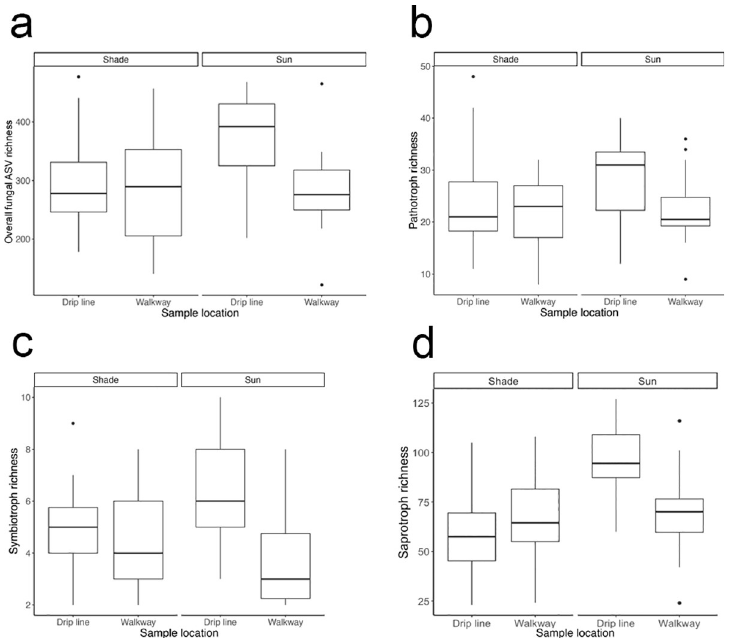
Fig 4. Boxplots of overall fungal richness and trophic mode richness by system and sampling depth. Each subfigure is plotted with system by sample location, but the interaction was only significant for subfigure d. Coffee soil collected in the drip line had higher a. overall fungal ASV richness, b. pathotroph richness, and c. symbiotroph richness than coffee soil collected in the walkway, regardless of system. d. Saprotroph richness was higher in the sun system when compared to the shade system, primarily driven by the drip line samples (interaction effect).